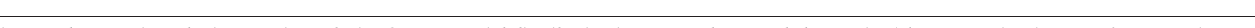
Figure 8 | Genomic and microscopic analysis of CTCF spatial distribution in c H2AX-decorated chromatin. ( a ) Genomic localization of g H2AX ChIP-Seq domains (coloured bars) and CTCF genomic footprint (dashed green lines) in a representative region of chromosome 16. Dashed black line: magnification. Coloured arrowheads: orientation of CTCF-binding sites (red: forward; green: reverse). Details about g H2AX ChIP-Seq domains are in Supplementary Methods and Supplementary Fig. 4. ChIP-Seq CTCF profiles were retrieved from publicly available databases (UCSC Accession: Encode wgEH000080, wgEH000543, wgEH000401 and wgEH000470). ( b ) CTCF occupancy outside or inside g H2AX ChIP-Seq domains. The intensity of each CTCF peak in 100kb bins upstream and downstream of the border of g H2AX ChIP-Seq domains (grey box) is summed and then presented as one-sided distribution. The bins range from ± 300 to ± 200, ± 200 to ± 100, ± 100 to 0 and 0 to ± 100kb (inside the domain), with 0 being the border of each domain. AU: arbitrary unit. Genome-wide CTCF footprint localization relative to g H2AX ChIP-Seq domains’ borders. For each domain, the distance in kb between its boundaries and the closest CTCF peak is measured and plotted as a bar (dashed lines). ( c ) Representative 3D-SIM images of immuno-stained g H2AX and CTCF before and during DDR. Scale bar, 500nm. ( d ) Quantification of the closest centroid-to-centroid distance between CTCF and g H2AX nano-foci from 3D-SIM images. Measured (filled boxes) and simulated (patterned boxes) distances are shown. The latter were obtained from simulated random distributions of CTCF and g H2AX nano-foci (100 iterations). ( e ) Quantification of maximum CTCF intensity in g H2AX nano-foci and in surrounding shells. Maximum CTCF fluorescence in the segmented space normalized over the maximum CTCF fluorescence of the entire nucleus is plotted. All boxes and whiskers are as in Fig. 1. n : measured distances ( d ) or analysed shells ( e ) from two independent experiments. d , e : Mann–Whitney test: P o 10 (cid:2) 3